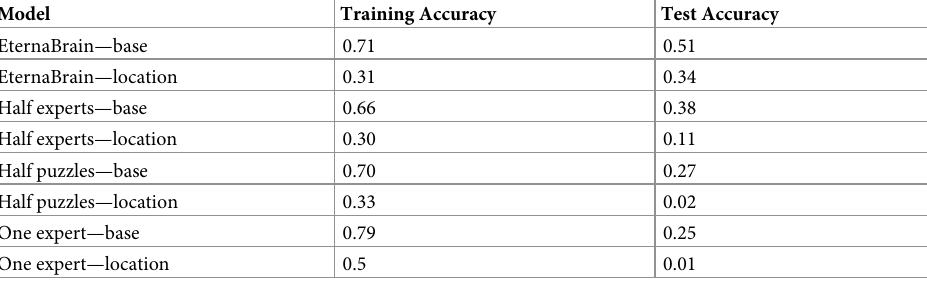
Table 2. EternaBrain CNN accuracies on eternamoves-select with different splits of training and test sets.